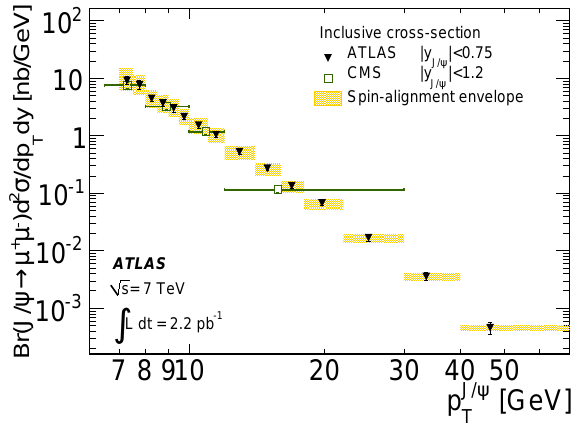
Fig. 3. Inclusive J /ψ production cross-section as a function of J /ψ transverse momentum in the